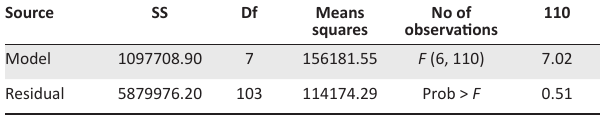
TABLE 1: Reliability test ( F statistic) .